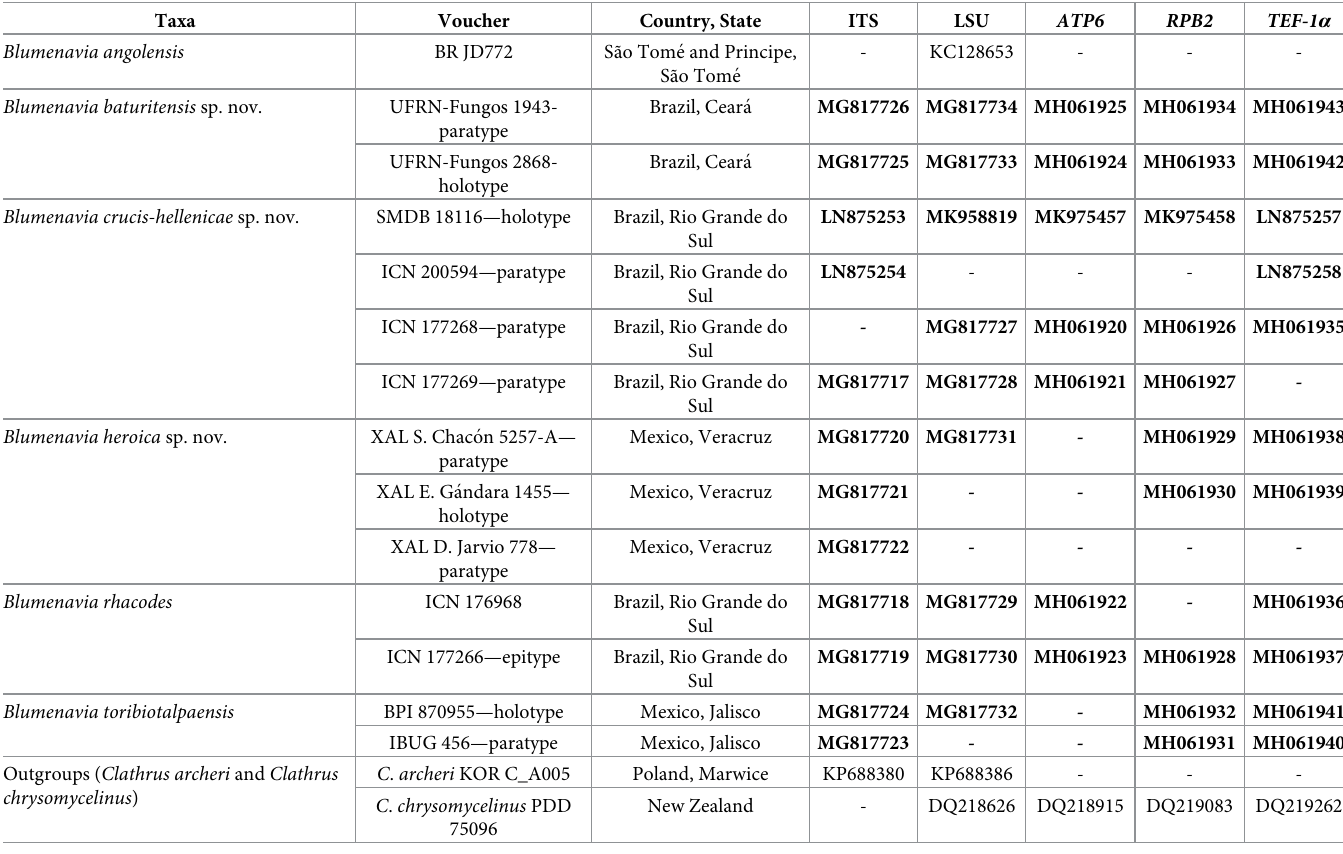
Table 1. Blumenavia specimens analyzed in molecular analysis. Genbank accession numbers for each region of the sequences included in this study. Accession num- bers in bold are from newly generated sequences. Absences of sequences are marked with “–”.